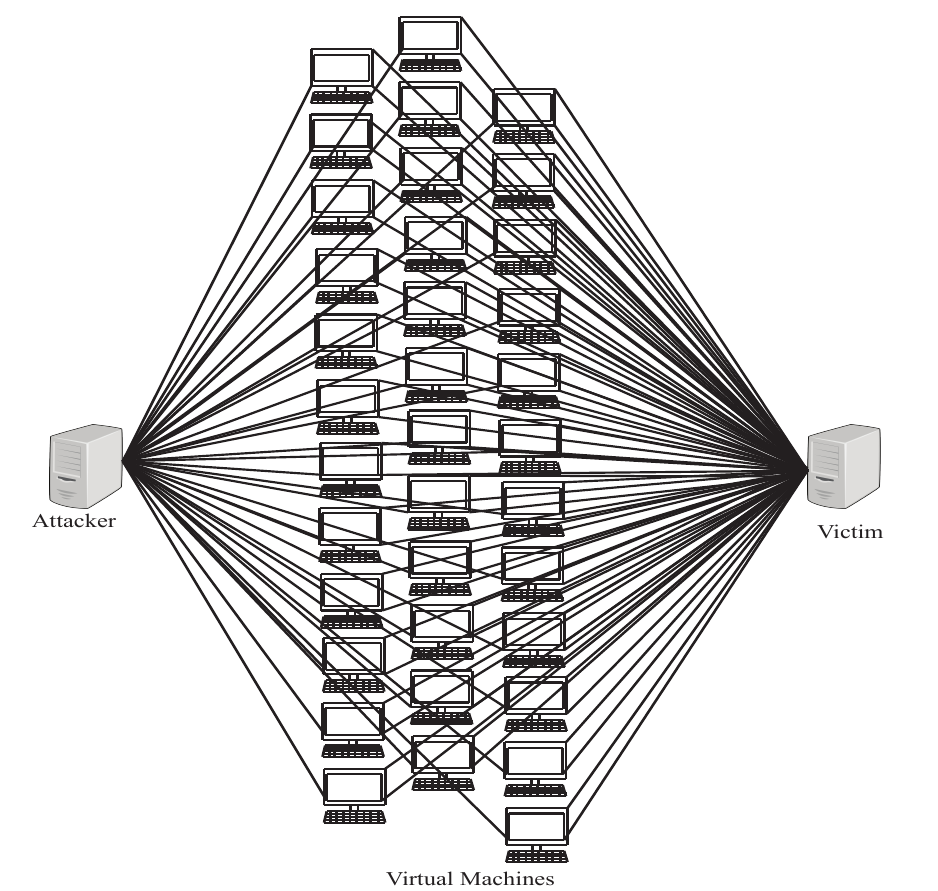
Figure 1. DDoS attacker and victim. Attacker spawn several Virtual Machines to slowdown the